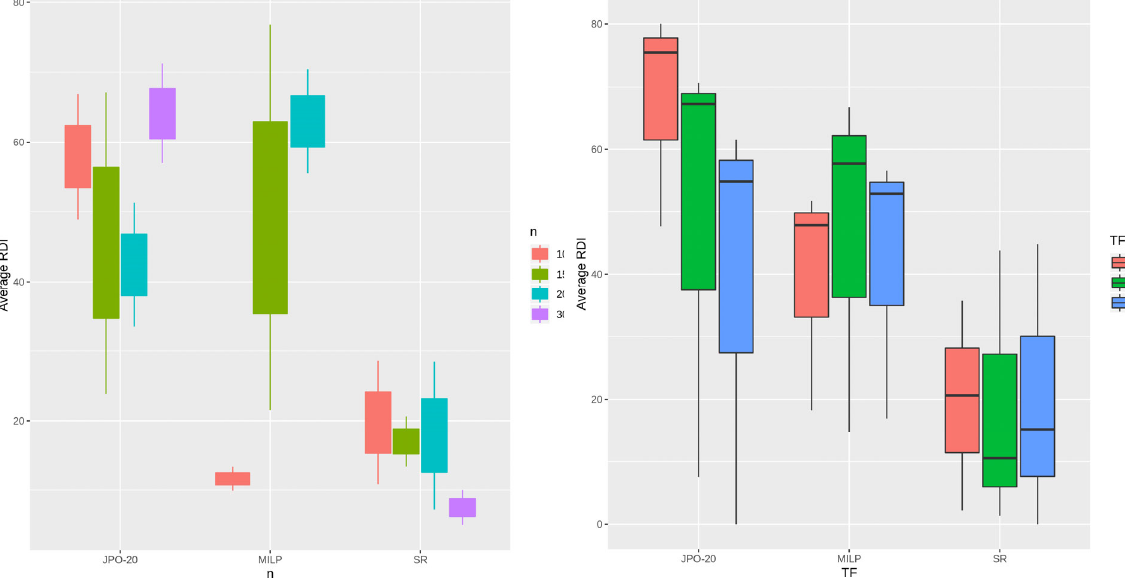
Fig. 4. Boxplots for average RDI values depending on n values Fig. 5 Boxplots for average RDI values depending on TF